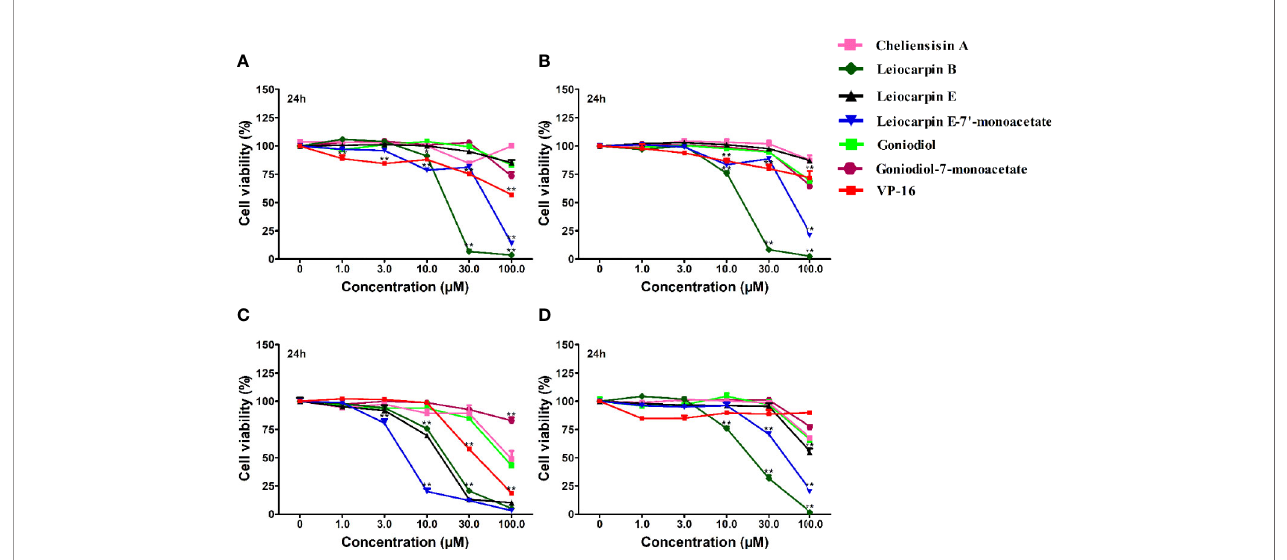
Table 5 ): MW= 276.28; triclinic, space group P 1; a = 5.4547 (5)